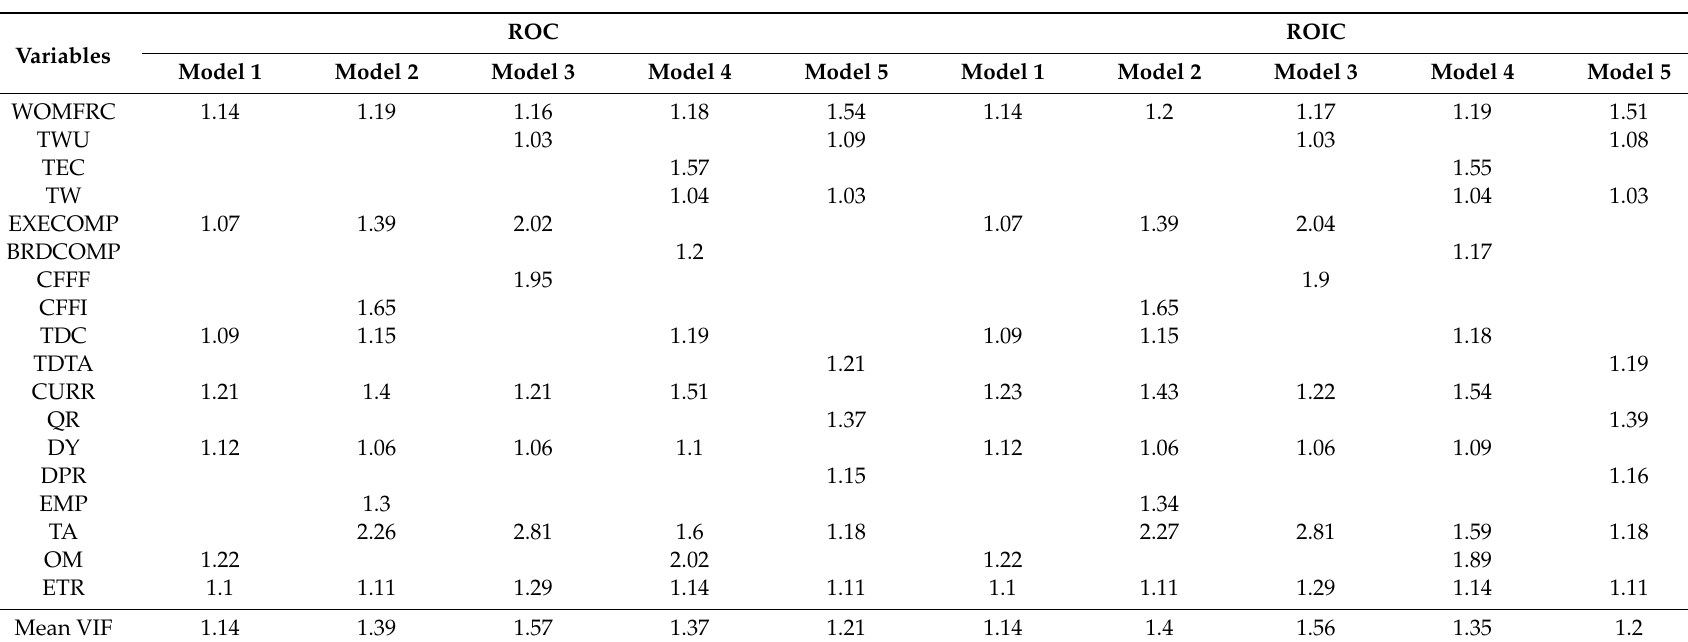
Table 12. VIFs for the panel data pooled regression models regarding the influence of water, waste, and energy consumption, alongside firm and corporate governance-specific variables, on return on capital and return on invested